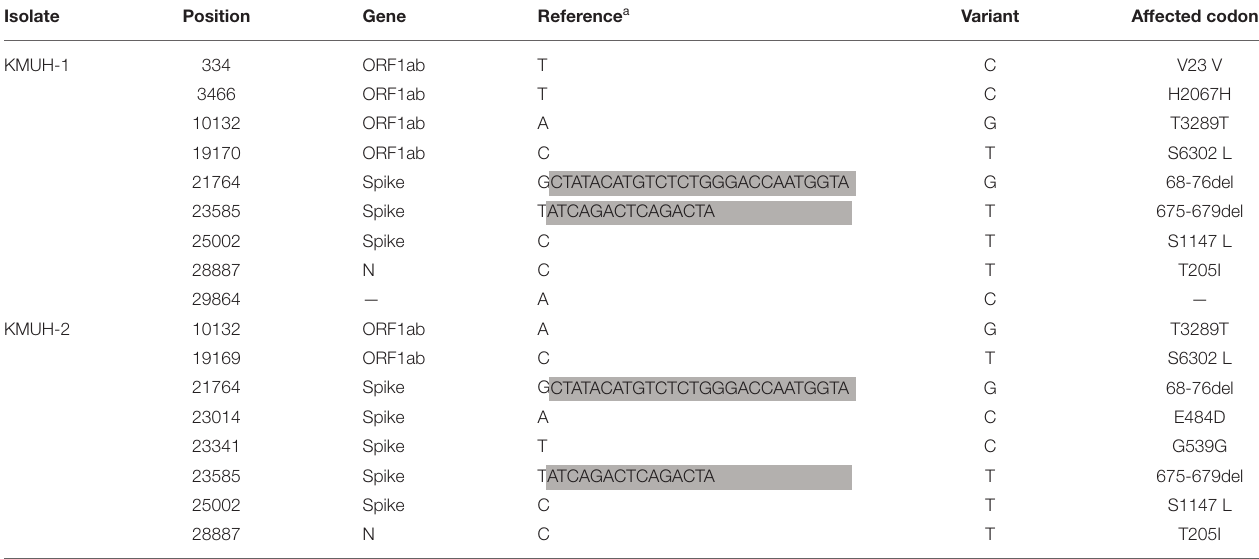
TABLE 2 | The sequence variation of KMUH-1 and KMUH-2 compared to the reference Wuhan-Hu-1/2019.